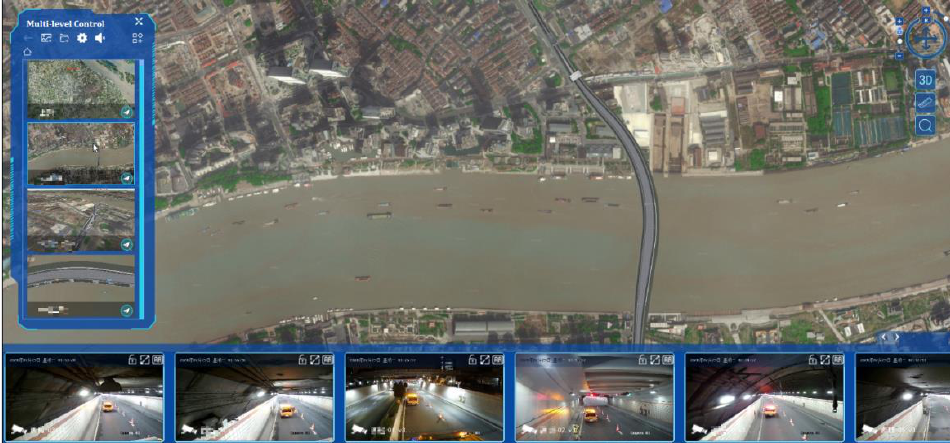
Figure 15. Two- and three-dimensional two-way linkage response operation.